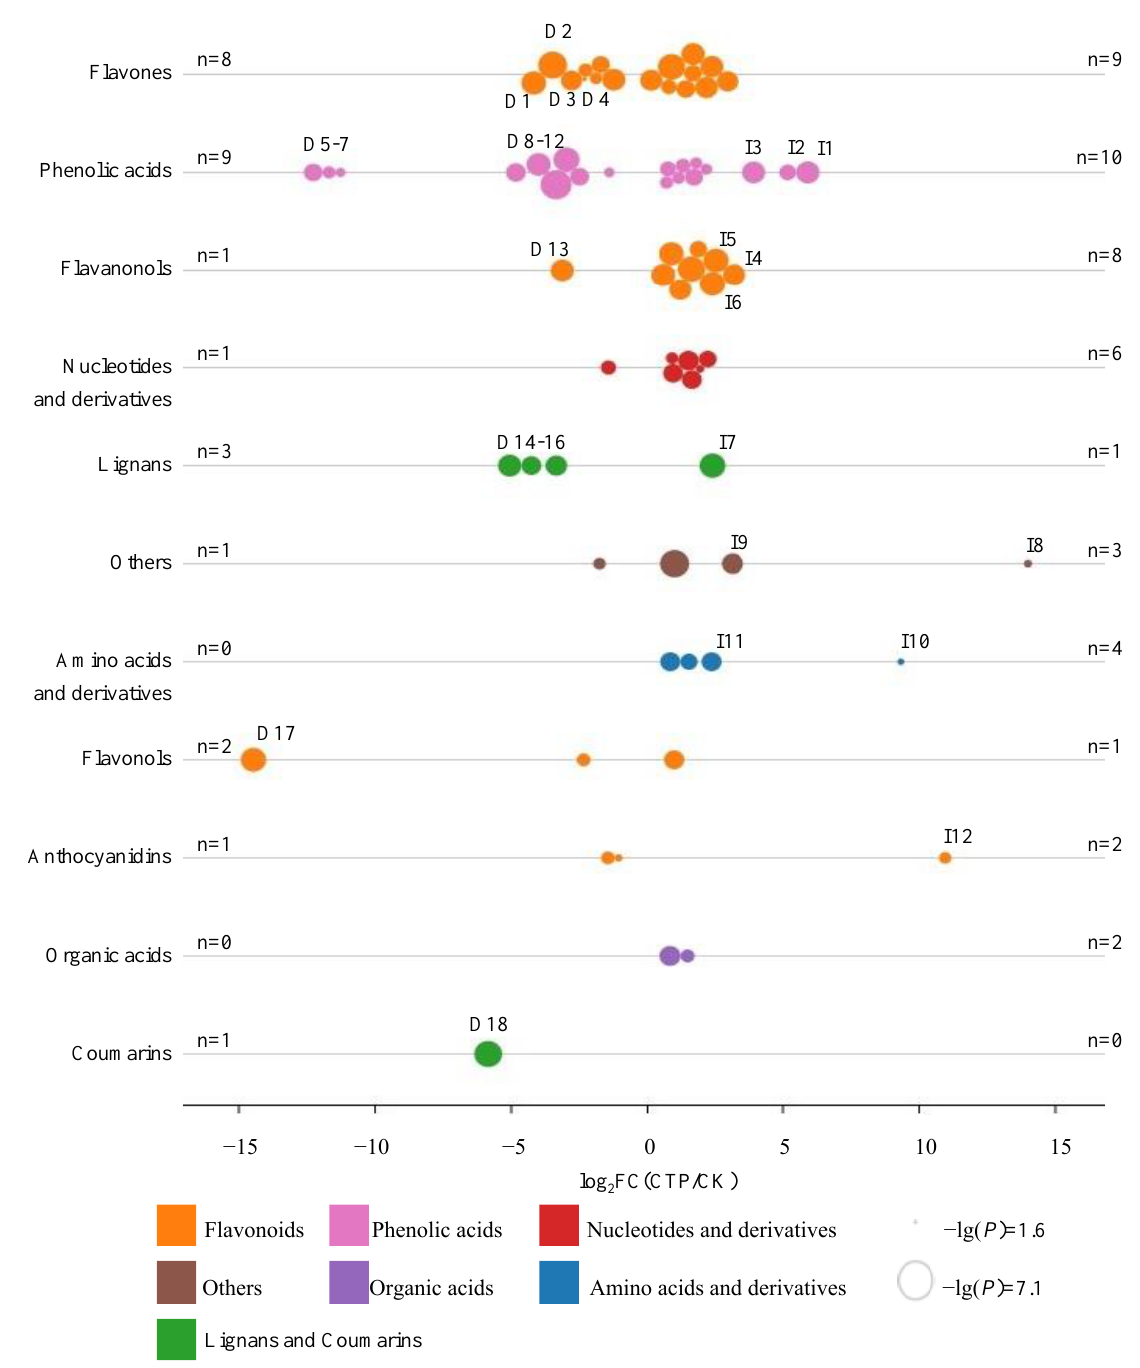
Figure 4. The differentially changed metabolites (DCMs) after catalysis with PPO. D1 – 18: acacetin-7- O - β -D-glucoside, acacetin-7- O -galactoside, tricin 7- O -hexoside, chrysoeriol, 3- O - p -coumaroyl shikimic acid O -hexoside, pyrocatechol, syringin, 5- O - p -coumaroyl quinic acid O -hexoside, 1- O -[(E)- p -cumaroyl]- β -D-glucopyranose, 2,5-dihydroxy benzoic acid O -hexside, protocatechuic acid-4-glucoside, 4-methylcatechol, diosmetin-7- O -galactoside, terpineol monoglucoside, pinoresinol-hexose, matairesinoside, quercetin 3,7-bis- O - β -D-glucoside, esculin. I1 – 12: coniferyl alcohol, esculetin, salicin, theaflavin 3, 3′ -digallate, theaflavin-3-gallate, theaflavin- 3′ -gallate, pinoresinol, MAG (18:1) isomer 2, resveratrol, L-methionine, L-homocystine, and peonidin.